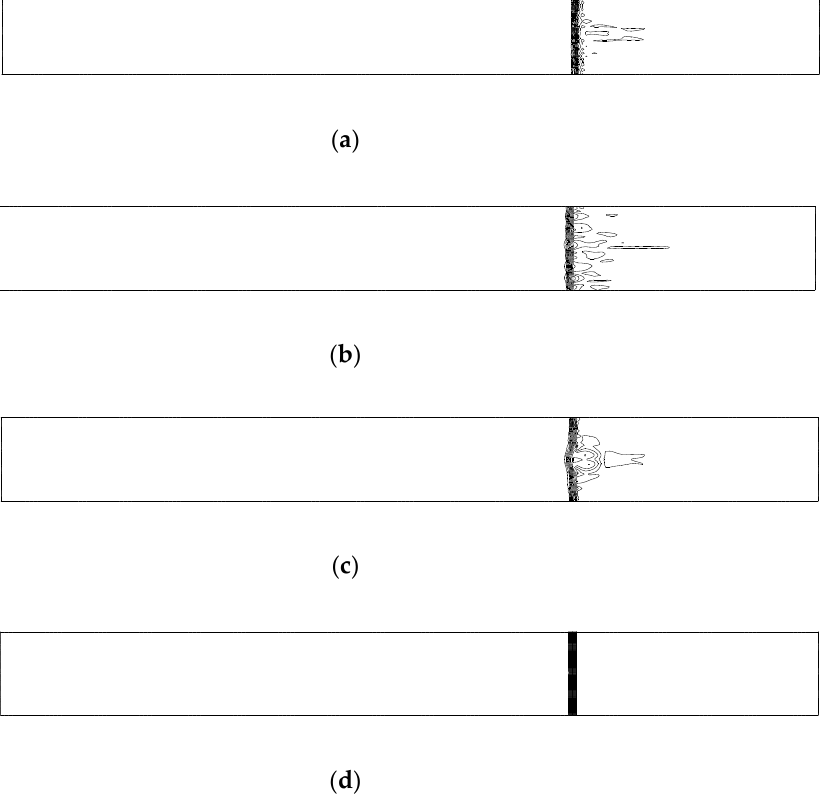
Figure 17. Density contours of the odd–even grid perturbation problem ( M s = 6.0, second order MUSCL reconstruction with the minmod limiter, ∆ x = 1); ( a ) AUSM+; ( b ) AUSMPW+; ( c ) SLAU; ( d ) AUSMAS.